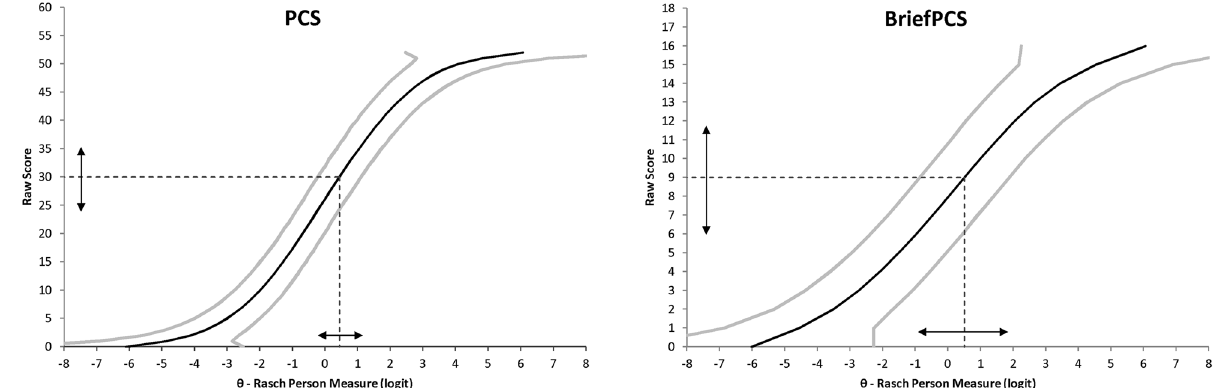
Figure 3. Conversion graph from total raw score (y-axis) to Rasch person measure (x-axis) for PCS and BriefPCS, with 95% confidence intervals (CI 95 , grey lines). Examples related to a score of 30 points for PCS (on the left) and of 9 points for BriefPCS (on the right): arrows delimit the CI 95 for those values (see also